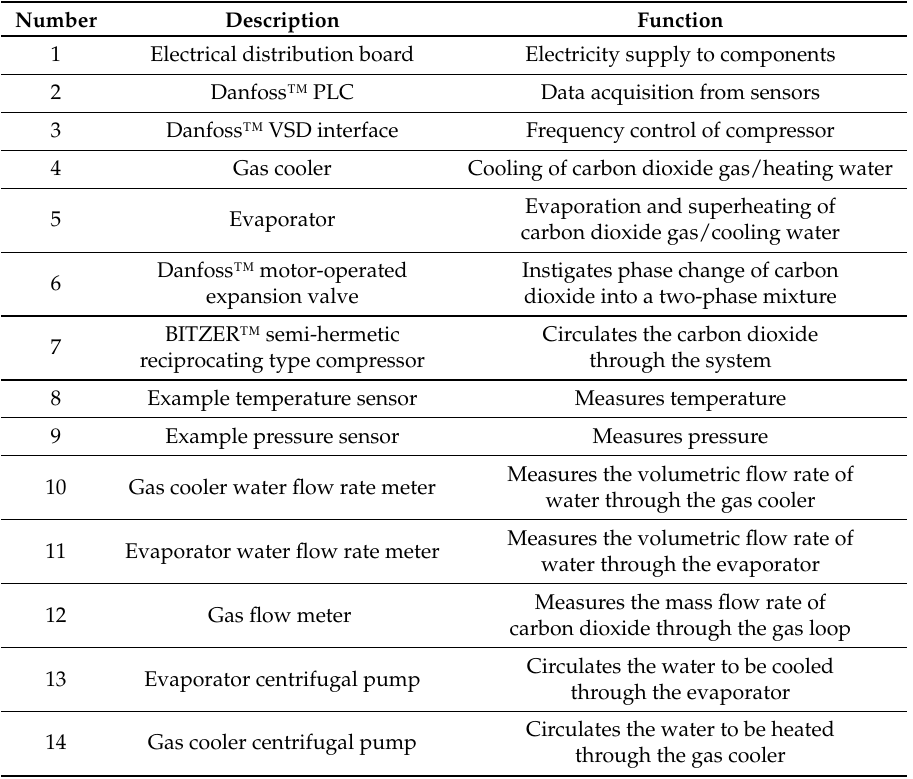
Table 1. Heat pump system component